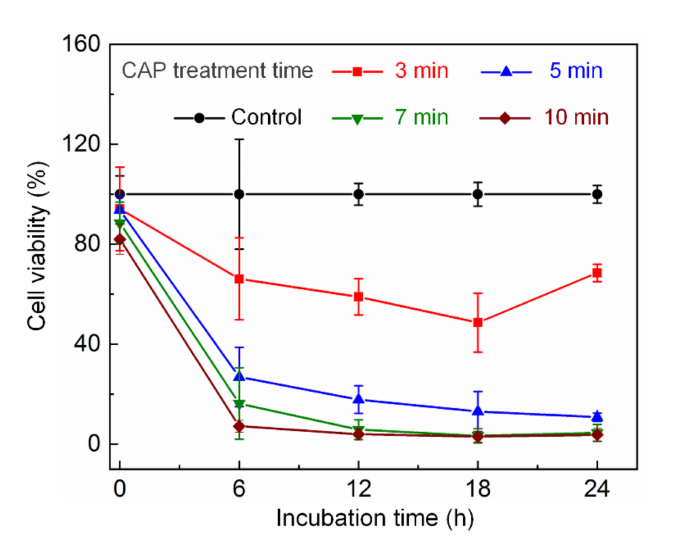
Figure 4. Variations of the HEK293 cell viability under different incubation durations and CAP treatment times.